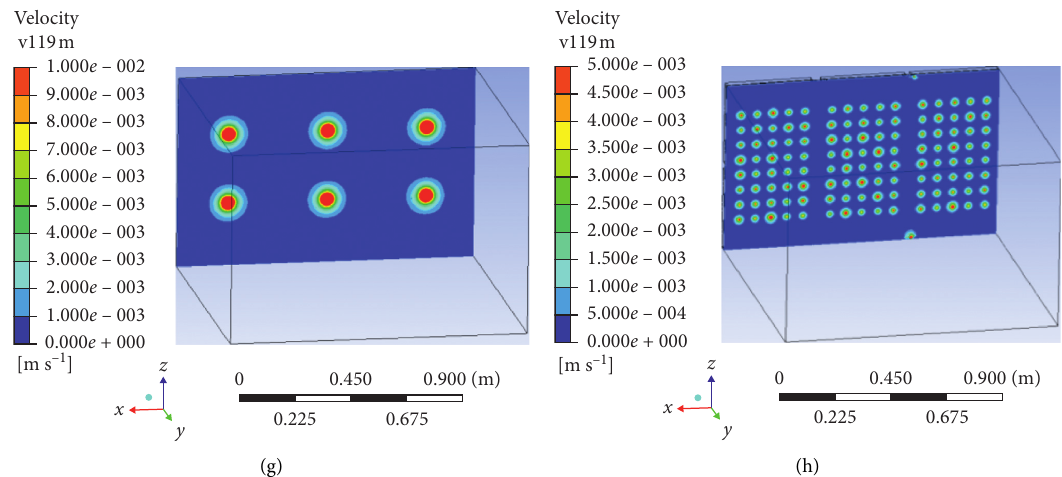
Figure 5: Comparison of porous plate effects: (a) without a porous plate, the hydraulic path length is 0.60 m; (b) with a porous plate, the hydraulic path length is 0.60 m; (c) without a porous plate, the hydraulic path length is 0.90m; (d) with a porous plate, the hydraulic path length is 0.90m; (e) without a porous plate, the hydraulic path length is 1.10m; (f) with a porous plate, the hydraulic path length is 1.10m; (g) without a porous plate, the hydraulic path length is 1.19m; (h) with a porous plate, the hydraulic path length is